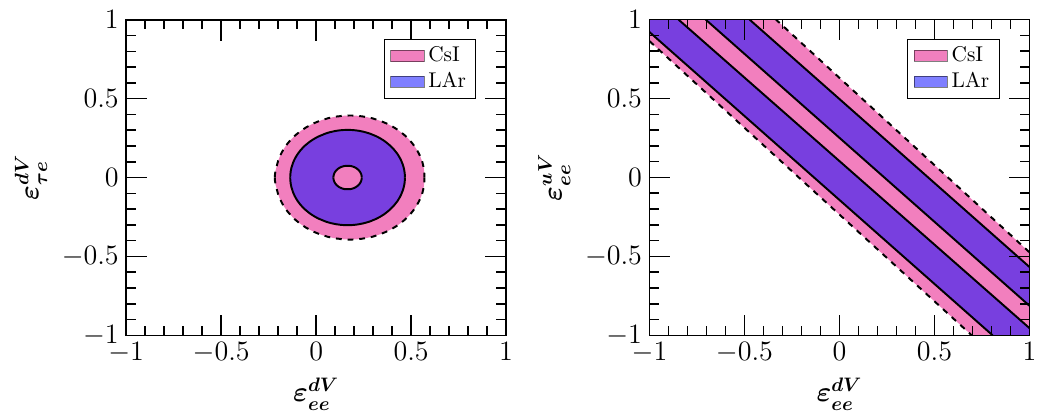
Figure 4 . 90% C.L. allowed regions from the analysis allowing two NSI parameters at a time. The left panel considers the simultaneous presence of non-universal and (cid:13)avor-changing NSI with d quark, while the right panel corresponds to the case of simultaneous non-universal NSI couplings with u and d quarks. For comparison, we show the results from the analysis of CsI and LAr data. left and right chirality projectors P L;R , and " fP are the couplings that quantify the (cid:11)(cid:12)